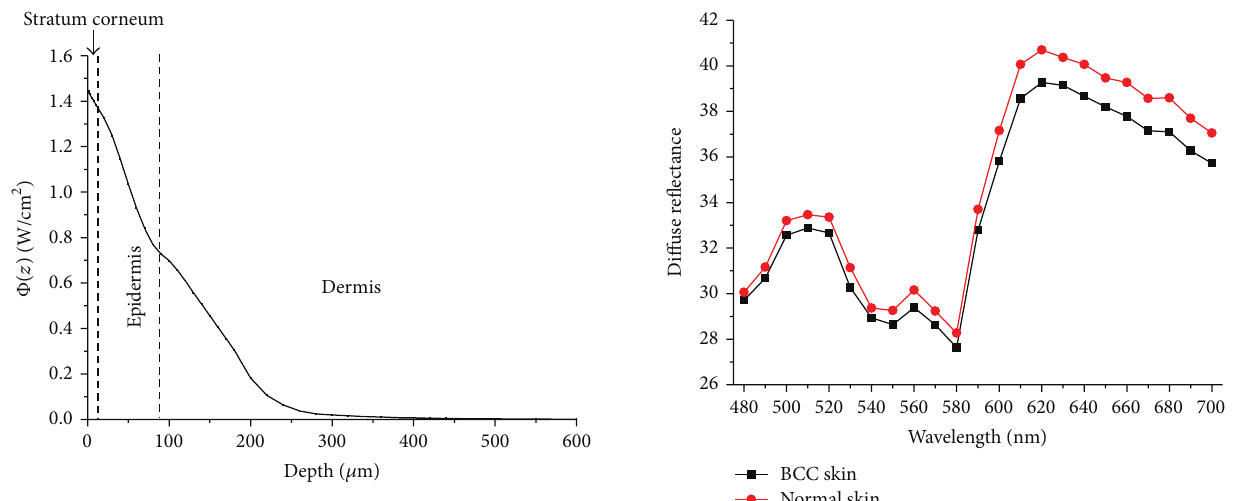
Figure 2: The excitation light (442nm) distribution as a function of depth 𝑧 inside the BCC skin tissue (5% blood factor added to the BCC layer).